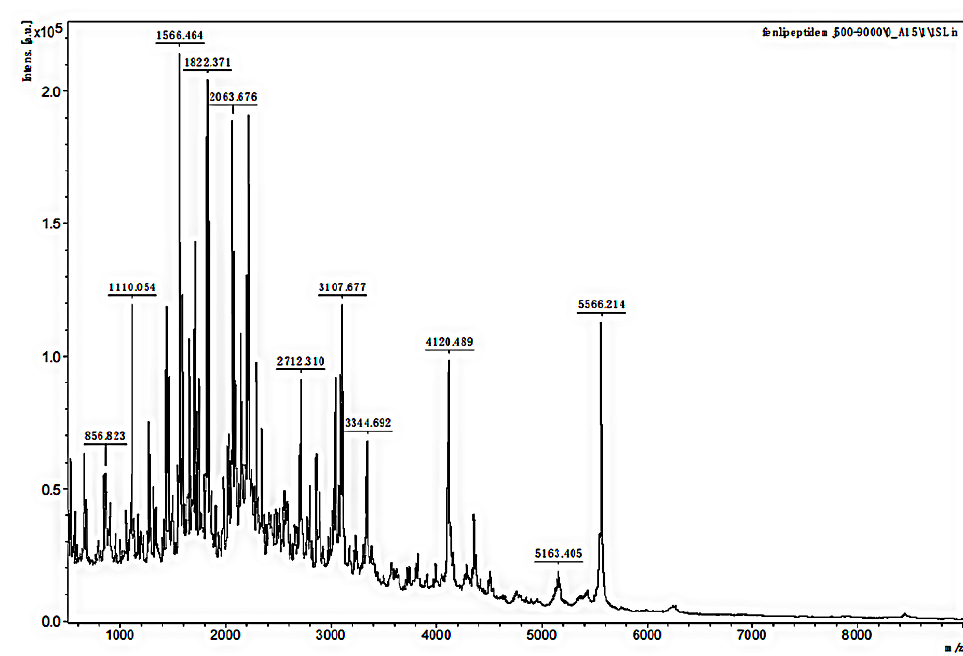
Figure 3. MALDI-TOF MS mass spectra of sample 1.